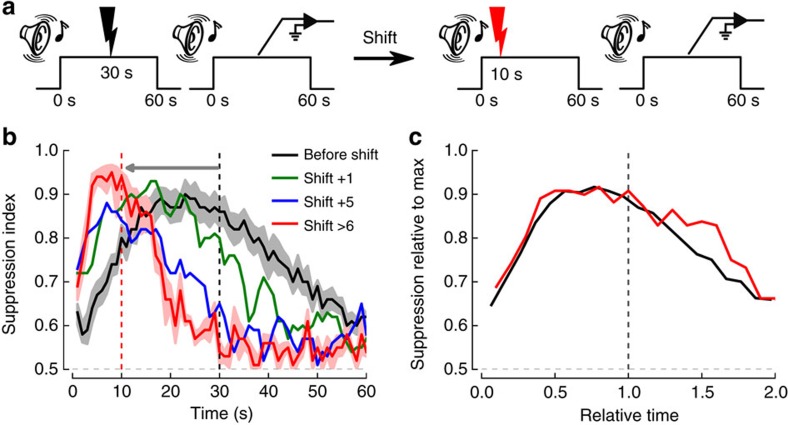
Conditioned suppression shows temporal expectancy that follows the scalar property after a change of the CS–US interval.(a) Graphical representation of the paradigm used to investigate correlates of interval timing. Note that the auditory CS does not co-terminate with the US arrival, thus enabling to isolate the temporal component of learning once all other contingencies have been acquired. Recordings during CS alone trials were analysed for interleaved sessions without access to lever. (b) Suppression index during CS presentation. Lever-pressing suppression increases from baseline (0.5) during the CS. Learning of the new time of US interval (10 s) occurs rapidly as the suppression curve shifted within one training day (black versus green curves) and stabilized at day 5 (blue and red curves). For clarity, s.e.m. are shown for the ‘before shift' (n=8) and ‘shift>6' curves only (n=6). (c) Suppression index for 30 and 10 s expected CS–US intervals on normalized axes. Relative time refers to normalization of time to the occurrence of the actual time of US arrival. To assess the scalar property without the confound of peak rate differences, both curves were also normalized to their respective maximal values. As predicted by the scalar property, the width of the curve was reduced in accordance with the time shift, as there was good superposition of both curves.